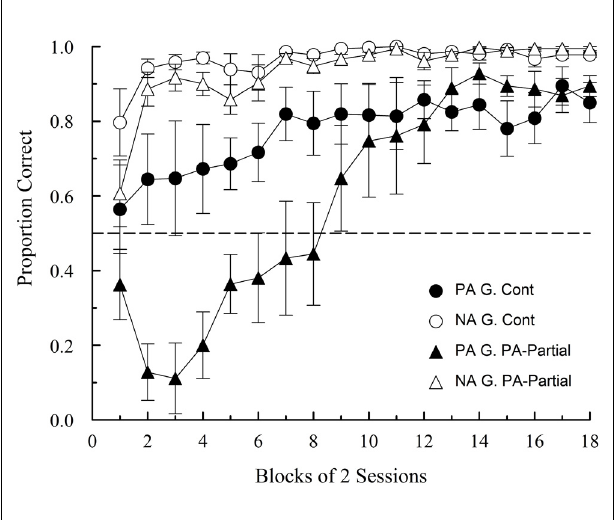
FIGURE 4 | Proportion of correct choices ( ± 1 SEM) on PA and NA trials during acquisition in Experiment 2. G denotes